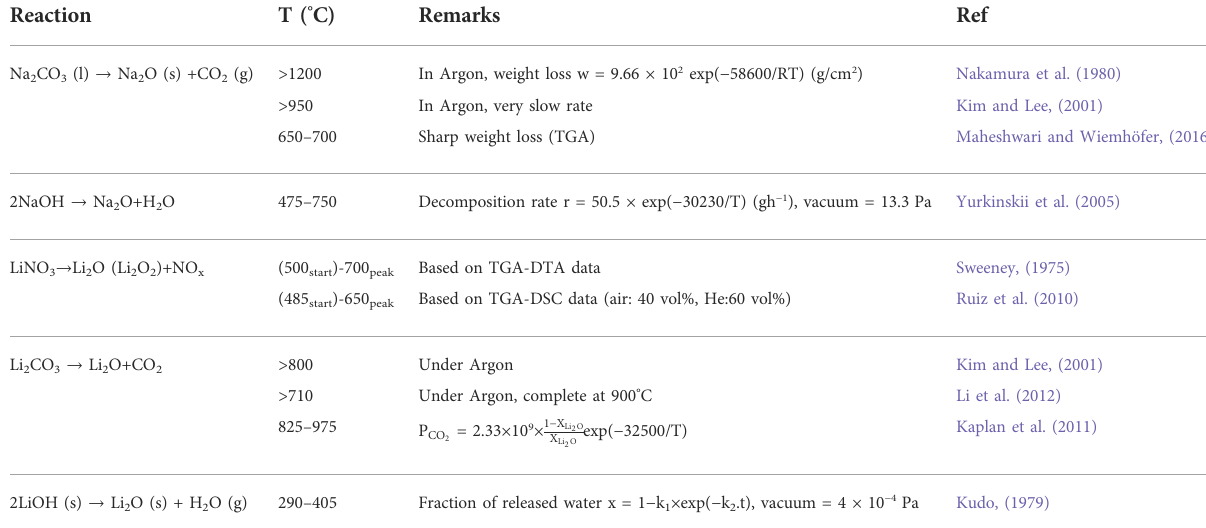
TABLE 4 Selected reactions involving alkali metal-based materials.